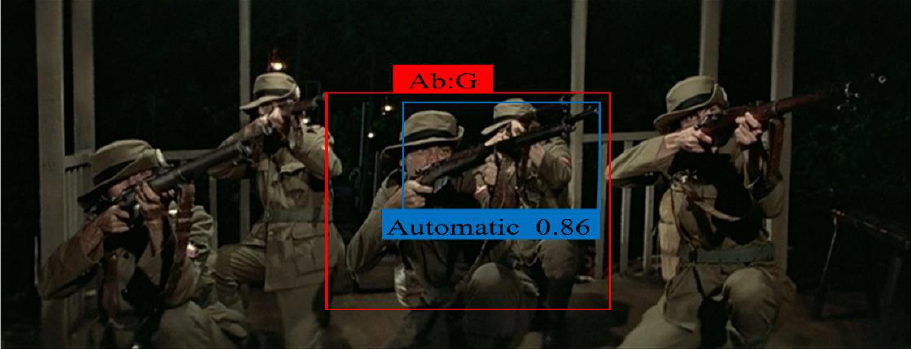
Figure 11. Depiction of a false negative, where there are three automatic guns in the background.